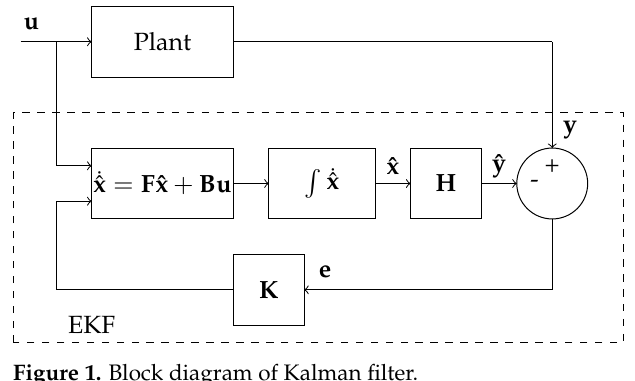
Figure 1. Block diagram of Kalman